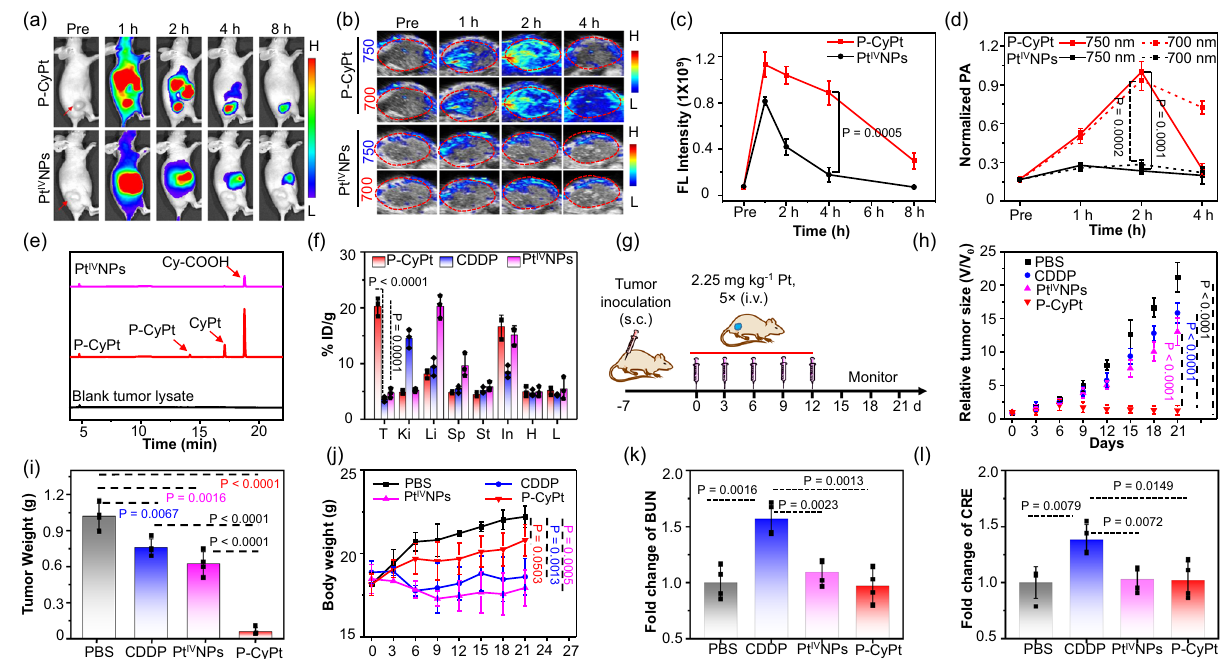
Fig. 4 | NIR FL/PA bimodal imaging and therapy of s.c. HeLa tumors in living mice with P-CyPt. a Longitudinal FL imaging, b dual PA imaging, c quanti fi ed FL intensityand d normalizeddualPAintensities(at700and750nm)ofHeLatumors receivingintravenous(i.v.)injectionofP-CyPtorPt IV NPs(100 μ M,200 μ L)at0,1,2, 4,and8h. e HPLCtraces(660nmdetection)ofthelysatesofHeLatumorsresected from mice at 4h post i.v. injection of PBS (black), P-CyPt (red, 100 μ M, 200 μ L) or Pt IV NPs (magenta, 100 μ M, 200 μ L). f ICP-OES analysis of Pt element shows the biodistribution(%ID/g)ofP-CyPt(red),CDDP(blue)andPt IV NPs(magenta)inHeLa tumors and main organs (T: tumor, Ki: kidneys, Li: liver including gallbladder, Sp: spleen,St:stomach,In:intestines,H:heart,Lu:lung)ofmiceat4hposti.v.injection